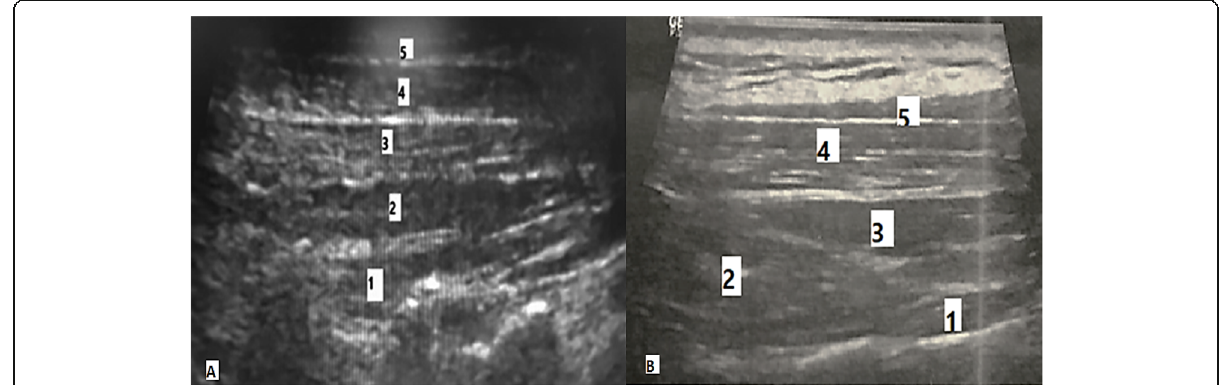
Fig. 2 a , b Ultrasound imaging of the dorsal neck muscles of two different patients show the (1) multifidus cervicis muscle, (2) semispinalis cervicis muscle, (3) semispinalis capitis muscle, (4) splenius muscle, and (5) trapezius muscle